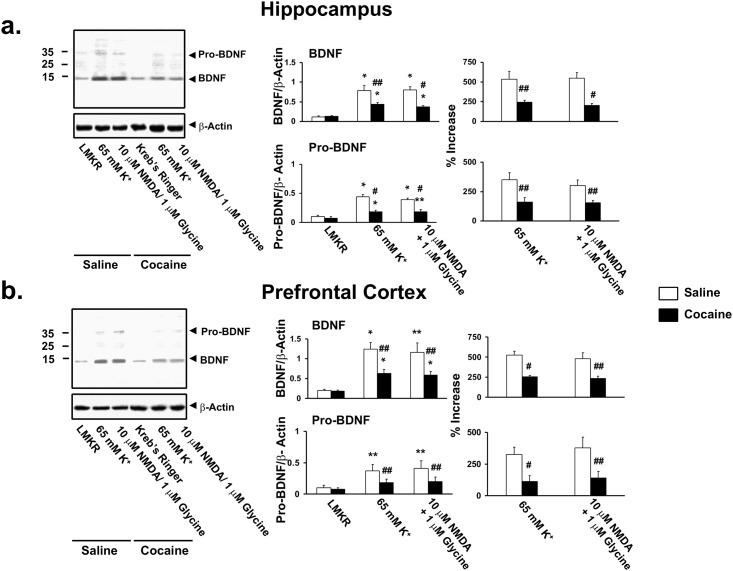
Prenatal cocaine exposure reduced NMDA/Glycine and K+-depolarization induced BDNF and proBDNF release in hippocampi (a) and PFCX (b).Hippocampal and PFCX slices prepared from P21 prenatal cocaine- and saline-treated rats were used to determine spontaneous BDNF/proBDNF efflux as well as BDNF and proBDNF release induced by 10-min 10 μM NMDA/1 μM glycine in LMKR or 1-min 65 mM K+-depolarization in a superfusion system. BDNF and proBDNF in the perfusate were then immunoprecipitated with immobilized anti- BDNF and determined by Western blotting with anti-BDNF. The brain slices were collected, homogenized and solubilized and the level of β-actin in the brain slices was determined by Western blotting to illustrate equal quantities of tissues. The blots were quantified by densitometric scanning. Data are expressed as means ± s.e.m. of the ratios of BDNF or proBDNF optical intensity to the optical intensity of β-actin. n = 6. **p < 0.05, *p < 0.01 compared to LMKR-treated in the same group. ##p < 0.05, #p < 0.01 compared to respective protein in the saline-treated group.